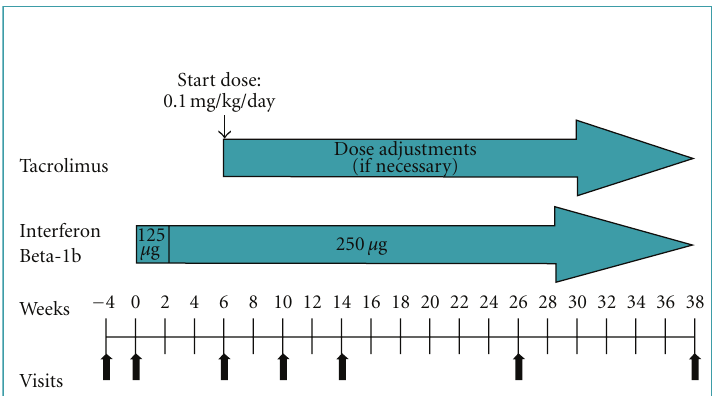
Figure 1: Study design. Relapse remitting and secondary progressive patients were randomized into low-blood-level (LBL) or high-blood- level (HBL) tacrolimus groups, in combination with Betaseron. Betaseron was administered subcutaneously every other day, while tacrolimus was given orally. Combination therapy was administered over a 38-week